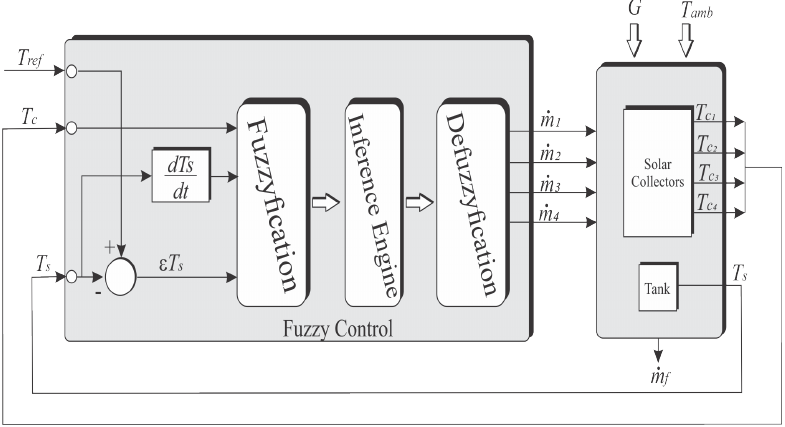
Figure 3. Layer 1: Fuzzy control of the solar collector